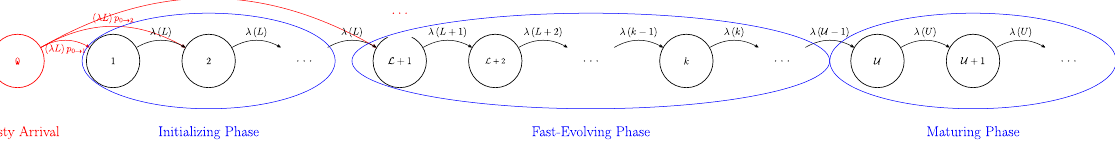
Figure 1. The state transition rate diagram of the MC for each particular arrived node (i.e. dynamic eq. (2) with trichotomy model eq. (1)), with its degree k as the state variable (with the burst occurred at k b = 0 as an illustration). The blue part represents the usual state transition (or developement) of the degree having trichotomy in its transition rate λ ˆ k according to its phase (wherein the transition is triggered by a single new node arrival). The red part represents the burst occurrence, i.e., some new node(s) coming at a rate of λ L simultaneously, with the rate of making i connections simultaneously with this existing node being λ LP 0 → i . Noted that the initial distribution of the degree of this arrived node is denoted as p i (0) for all degree i , is not shown in the